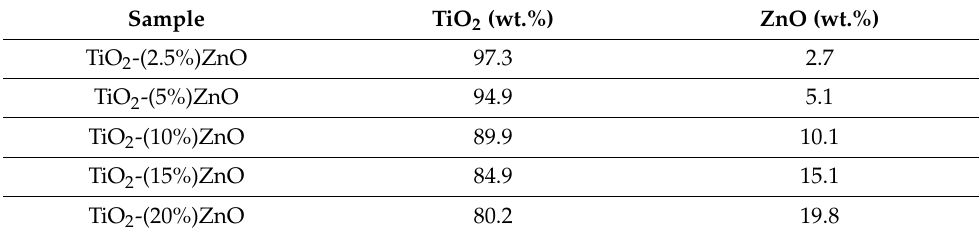
Figure 8. The results of EDX mapping for: ( a ) TiO 2 -(2.5%)ZnO, ( b ) TiO 2 -(5%)ZnO, ( c ) TiO 2 -(10%)ZnO, ( d ) TiO 2 -(15%)ZnO, ( e ) TiO 2 -(20%)ZnO systems. Table 4. The results of EDXRF analysis for TiO 2 -ZnO